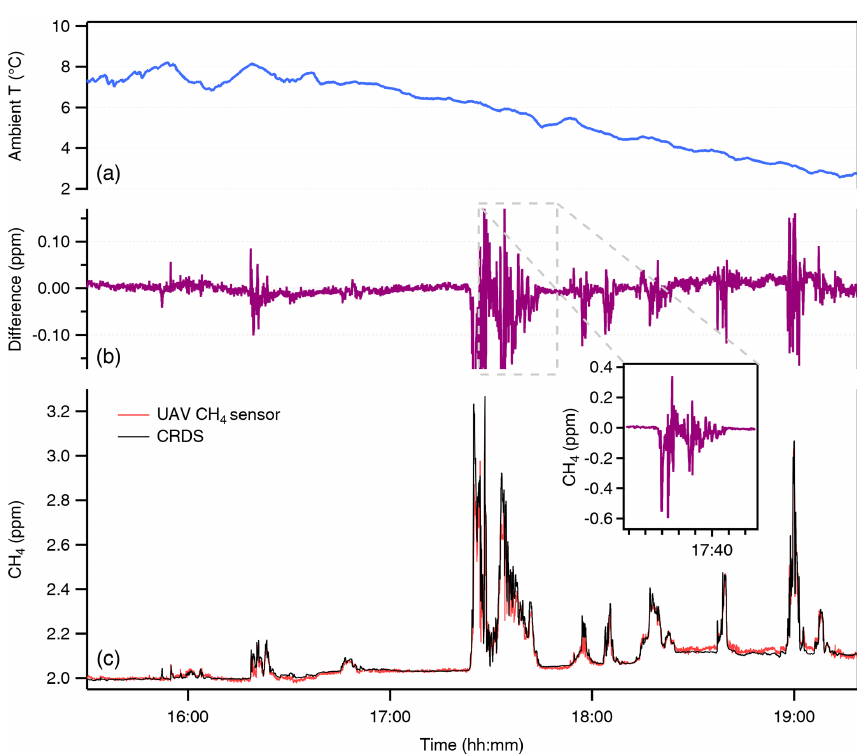
Figure 6. Intercomparison of the CH 4 spectrometer with a reference methane analyzer at the NABEL monitoring station (time zone: CET). The device was placed outside, fully exposed to changing environmental conditions, in the proximity of the air inlet located at 2m above ground. The recorded time series and the difference in the CH 4 concentration between the two analyzers are shown in the (c) and (b) plots. The period of large variation in the atmospheric methane concentration is detailed in the inset figure. The variation in the ambient temperature during the measurements is given in the (a)